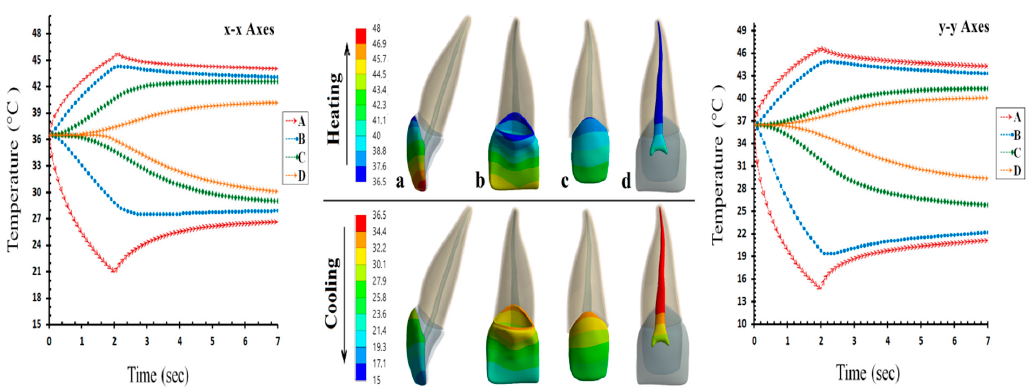
Figure 8. Temperature distributions in the non-preparation design along the x-x and y-y directions.